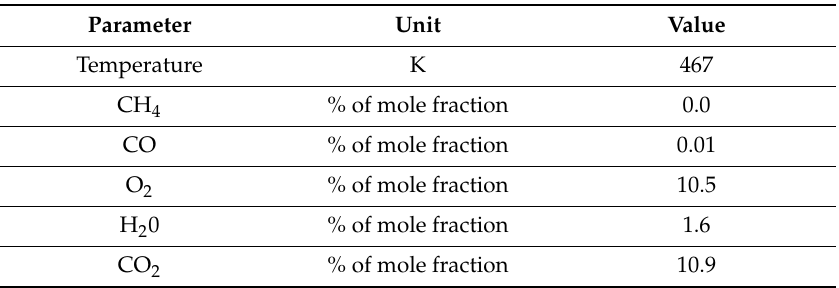
Figure 11. Temperature distribution (K) and gas paths in the boiler model with deflector. Table 4. Conditions in the chimney